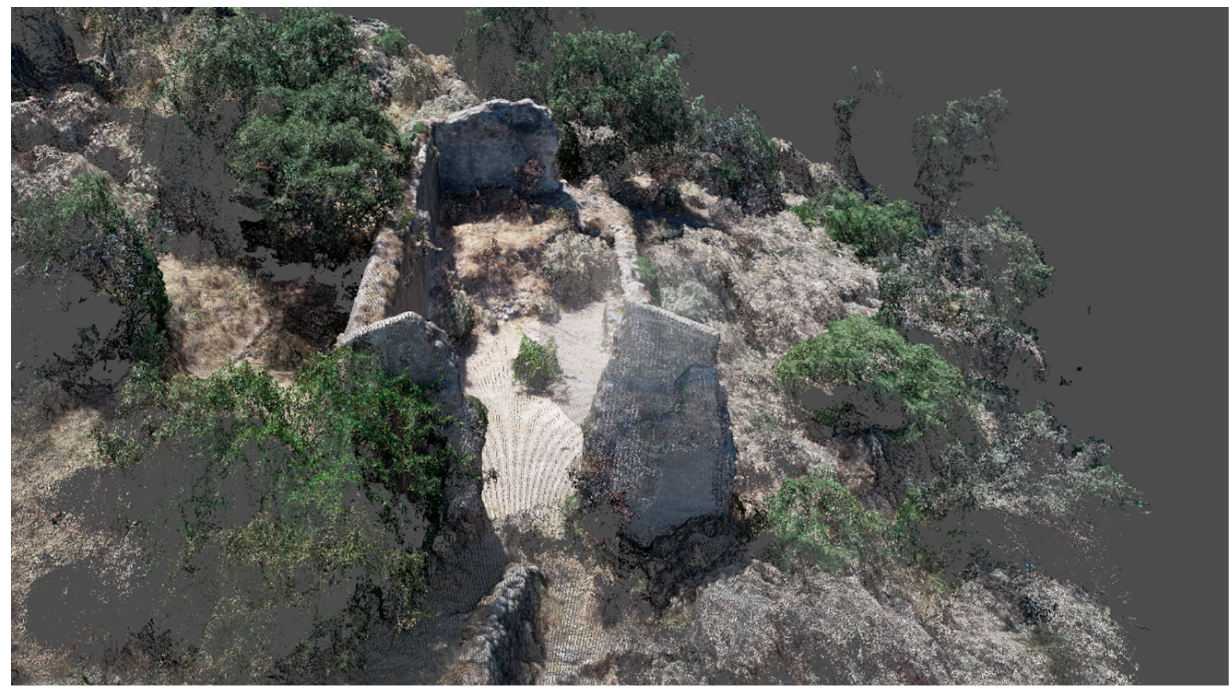
Figure 19. 3D dense cloud of the Church of San Nicola derived from UAV photogrammetry.